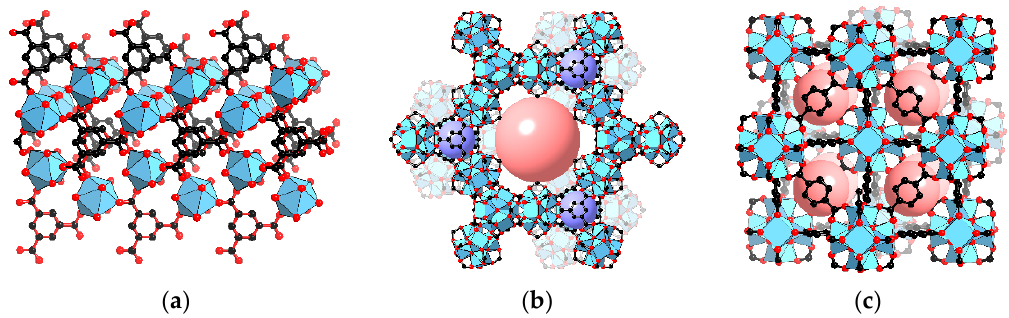
Figure 1. The structural diagrams of ( a ) Ce-BTC, ( b ) Ce-MOF-808, and ( c ) Ce-UiO-66. Blue polyhedron: Ce cluster; red ball: O; black ball: C; pink and violet ball: pore.